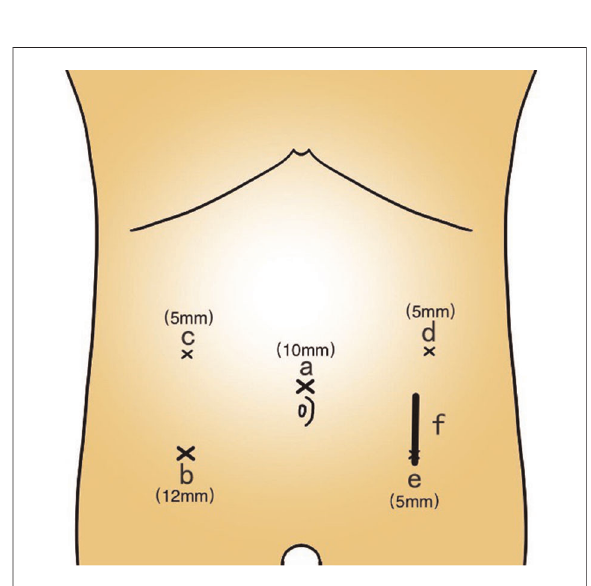
FIGURE 2 Trocar placement. ( A ) Camera port for laparoscope. ( B ) Manipulation port. ( C – E ) Assistant ports. ( F ) Abdominal incision extended for specimen resection and extraction (approximately 5